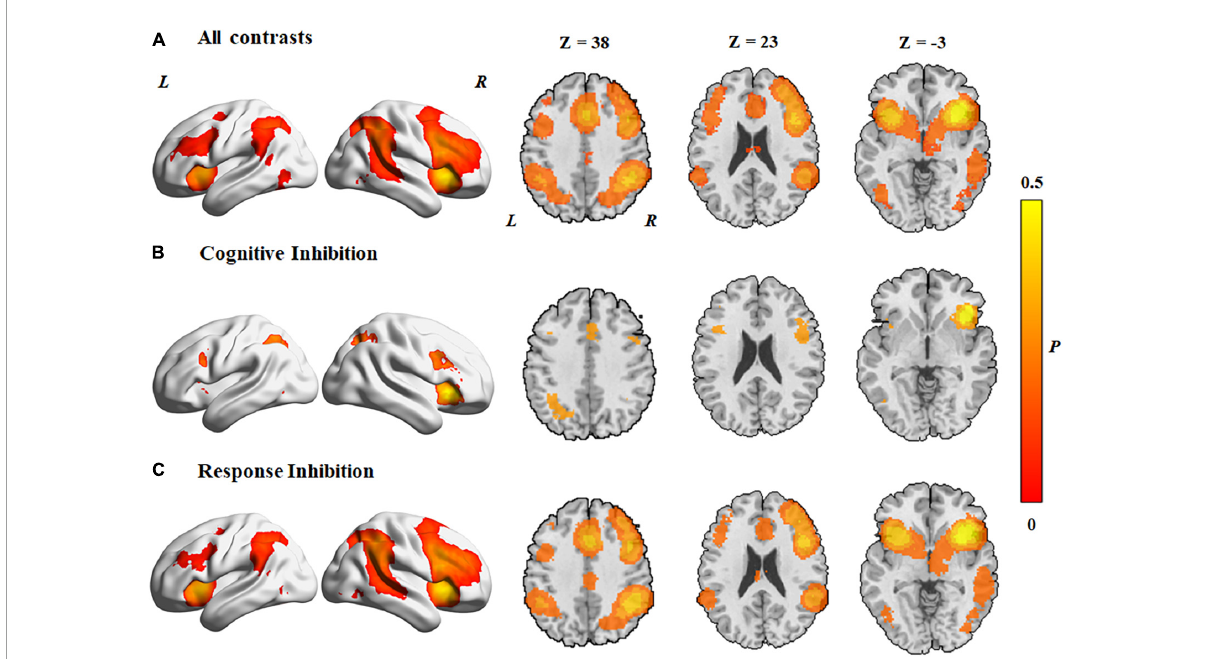
FIGURE2 Concordance of brain activation from the MKDA analyses. (A) Brain areas activated by all contrasts. Brain areas activated in (B) cognitive inhibition and (C) response inhibition. The color bar represents the proportion of studies exhibiting the effect at the peak density weighted by sample size